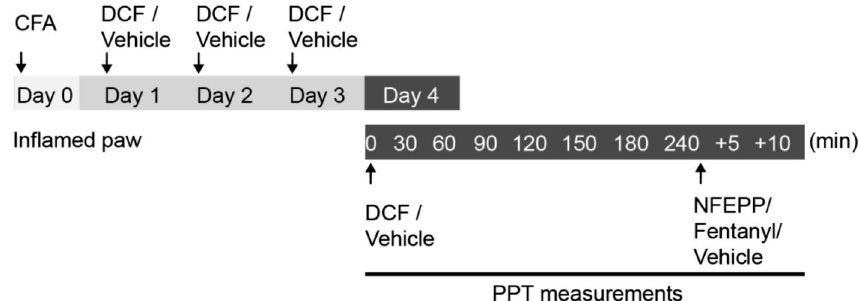
Figure 1. Experimental protocol. Complete Freund’s adjuvant (CFA) was injected intraplantarly (i.pl.) into the right hindpaw on day 0. Diclofenac (DCF) or vehicle were injected subcutaneously (s.c.) daily for 4 days starting 24 h after CFA (day 1). The paw pressure threshold (PPT) was assessed 4 days after CFA before (0 min) and 30–240 min after the last DCF/vehicle application. After that, NFEPP, fentanyl or vehicle were administered i.pl. into the inflamed paw and PPT was measured again 5 and 10 min later (+ 5 and +